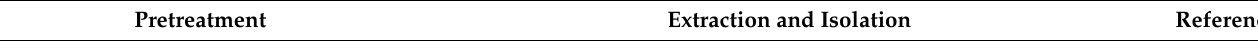
Table 3. Pretreatment, extraction and isolation methods for collagen production from